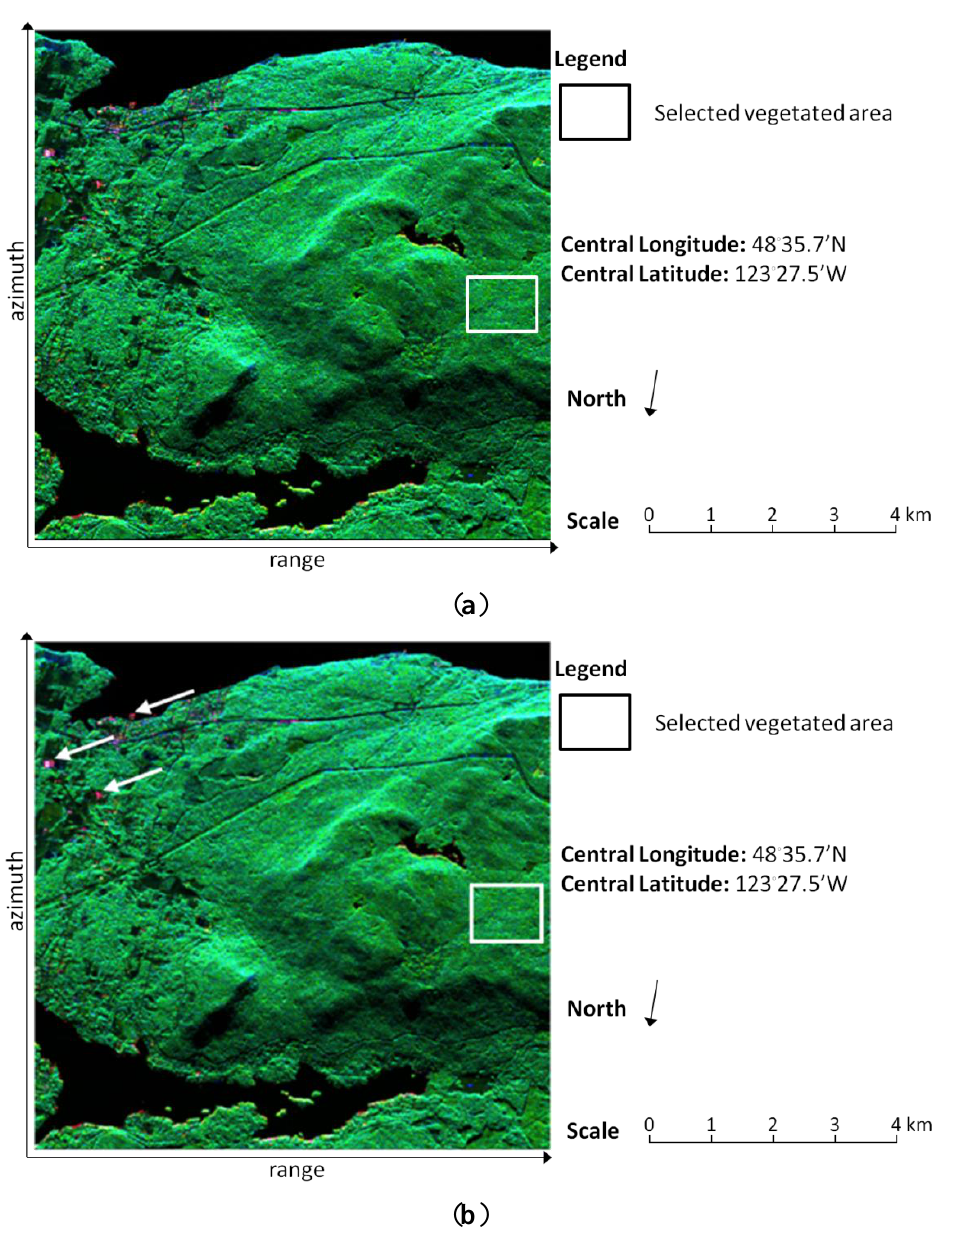
Figure 2. ( a ) Original Freeman-Durden decomposition result for AIRSAR data; ( b ) Proposed adaptive decomposition result for AIRSAR data; ( c ) Map of